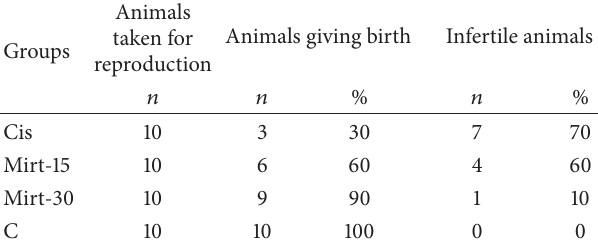
Table 2: Reproduction and infertility rate in the study groups.